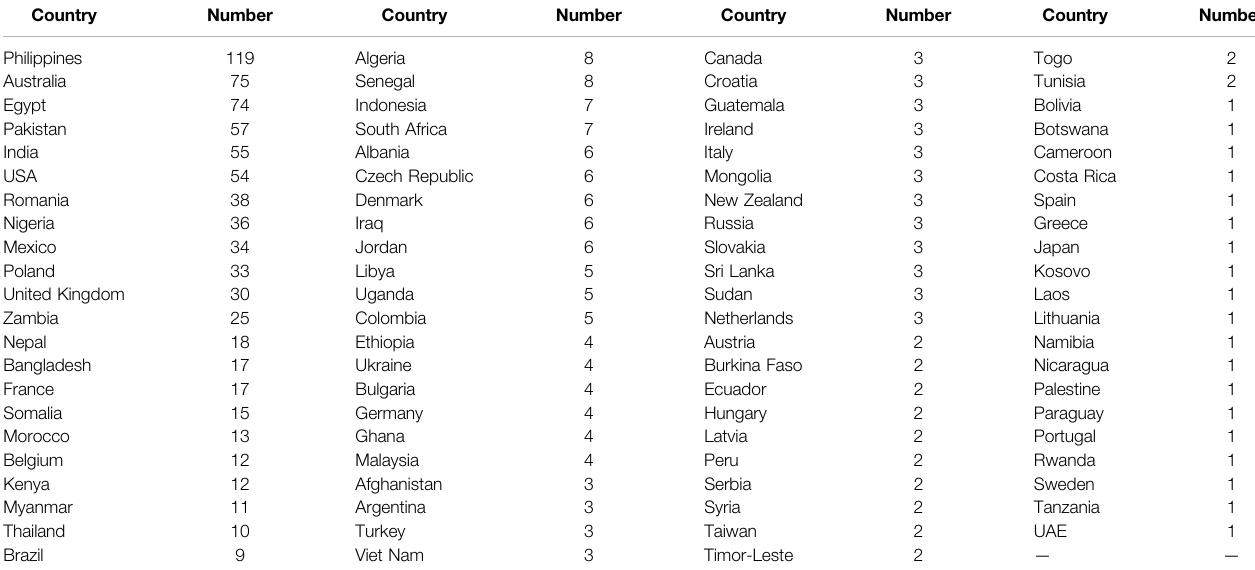
TABLE 1 | Number of participants from different countries. Country